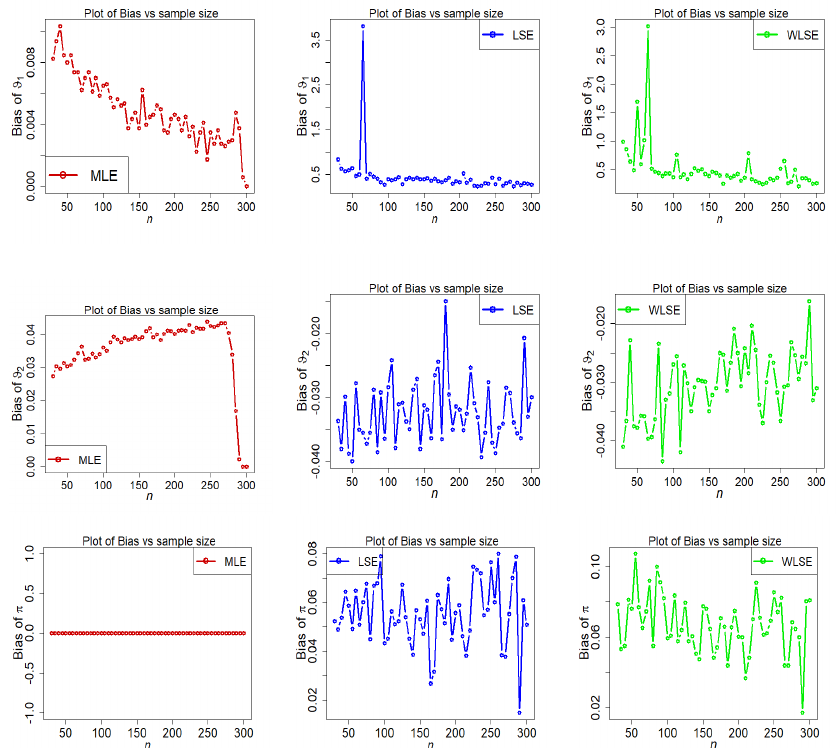
Fig. 8. Fluctuations of MSE of estimators under di⁄erent methods for parametric set I.